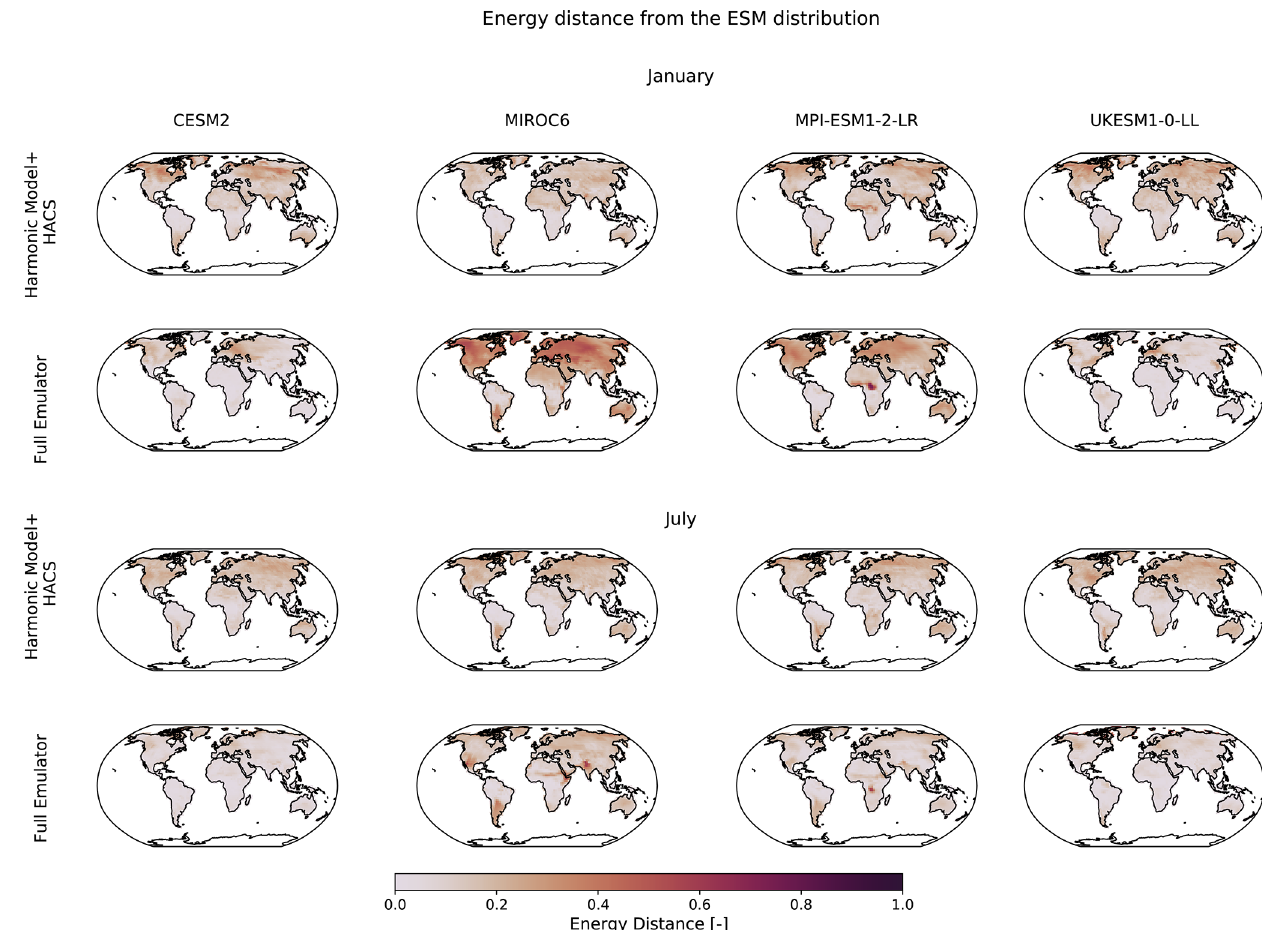
Figure 13. Comparison of the performance of the harmonic model + physically informed HACS model to that of the full emulator for January and July of four selected CMIP6 models. The energy distance from the actual model test runs is considered, where 0 indicates the best